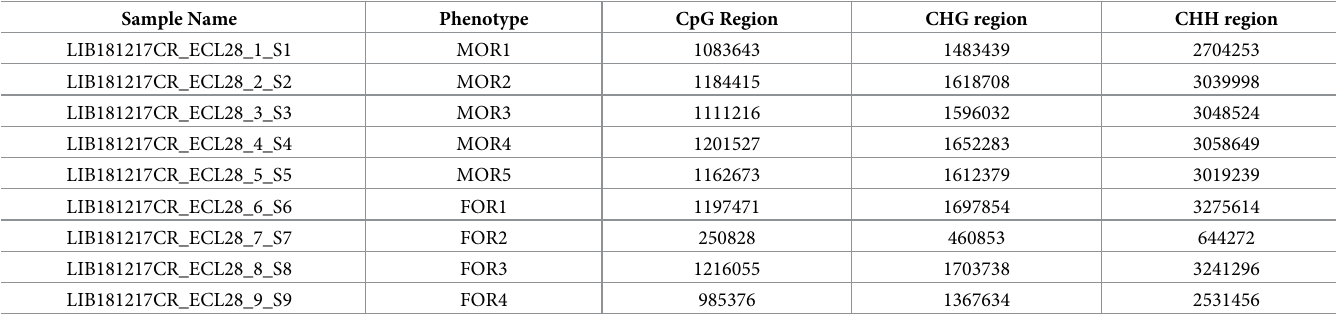
Table 3. Methylation sites per